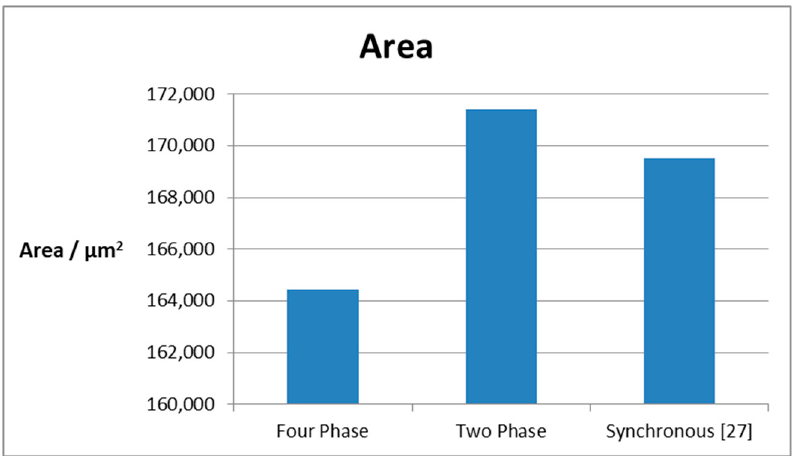
Figure 9. The area comparison among the three protocols for circuit-switched NoCs.